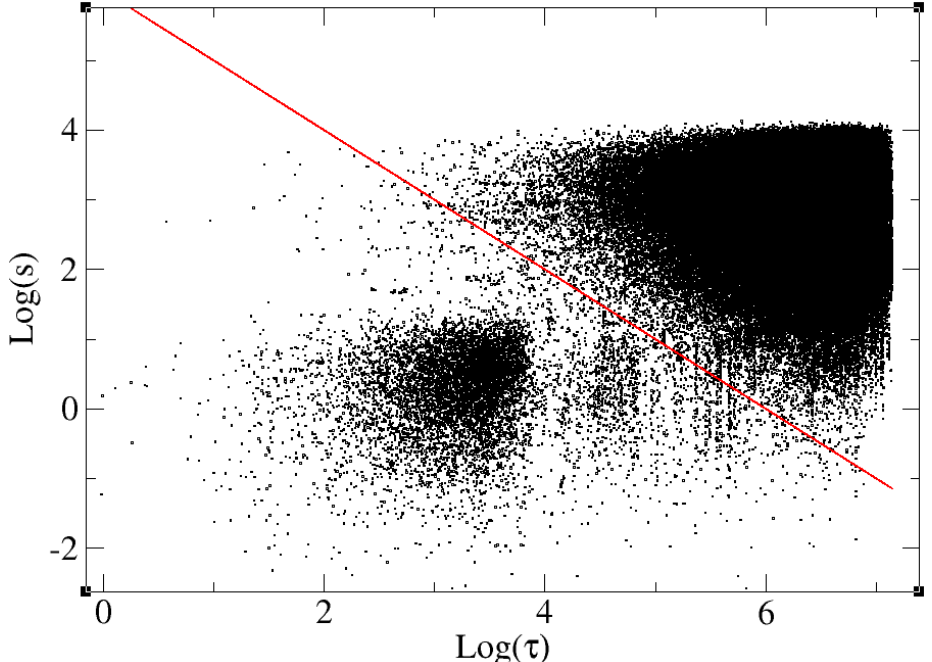
Figure 1. Bimodal distribution of time and space components of the nearest-neighbor for the observed seismicity in Italy. Solid red line corresponds to log 10 ( s ) + log 10 ( τ ) = 6. The fractal dimensionality is fixed at d =